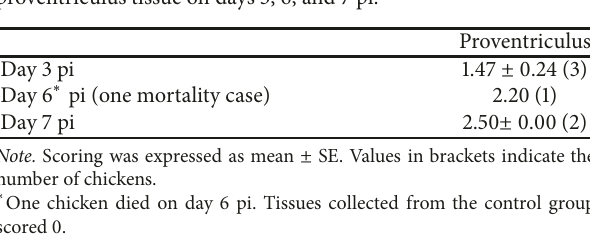
Table 2: Lesions scoring (0-4) induced by vNDV in HE stained proventriculus tissue on days 3, 6, and 7